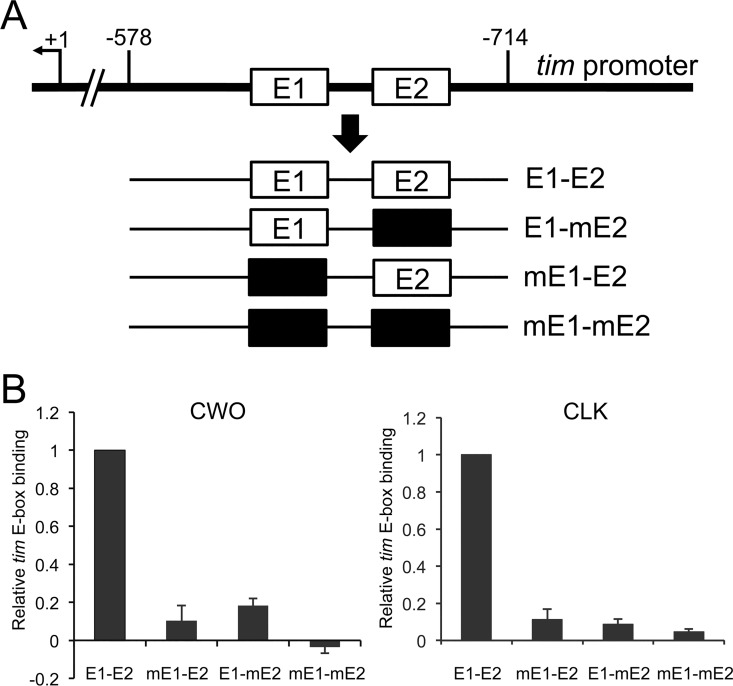
CWO and CLK bind the same tandem E-boxes in the tim circadian enhancer.(A) Schematic diagram of wild-type and mutant tim circadian enhancer transgenes. A 136bp tim circadian enhancer fragment that extends from -578 to -714 relative to the tim transcription start (+1; see [24]) was used to generate transgenes with wild-type or mutant combinations of tandem E-box 1 (E1) and E-box 2 (iE2) motifs. Wild-type and mutant tim circadian enhancer fragments were generated via PCR, cloned into the pHPdesteGFP reporter plasmid, and used to generate transgenic flies via PhiC31 recombination (see Materials and Methods). The resulting tim circadian enhancer transgenes contain wild-type E1 and E2 (E1-E2), mutant E1 and wild-type E2 (mE1-E2), mutant E2 and wild-type E1 (E1-mE2), or mutant E1 and E2 (mE1-mE2) E-boxes. Black boxes, mutant E1 or E2 E-boxes; double backslash, virtual break in the tim promoter sequence. (B) ChIP assays on flies containing the E1-E2, mE1-E2, E1-mE2 or mE1-mE2 tim circadian enhancer transgenes. The relative level of CWO binding at ZT2 or CLK binding at ZT14 was determined as described in Fig 2A. Relative binding of CWO or CLK was normalized to the maximum E1-E2 value of 1.0, then the means of each data set were calculated and plotted. Error bars represent the SEM (n = 3).